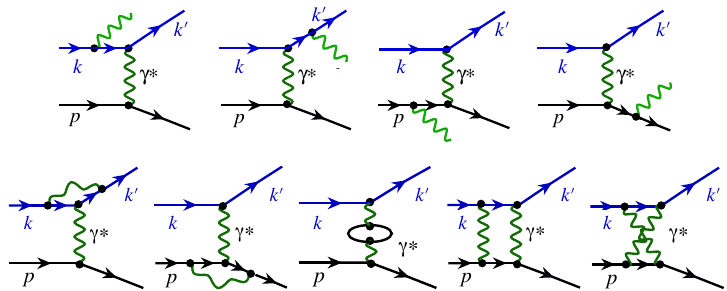
Figure 2 . Diagrams for the first real (top row) and virtual (bottom row) QED radiative contribu- tion to scattering of a lepton (momentum k ) from a quark ( p ) to a lepton ( k 0 ) and recoiling quark.